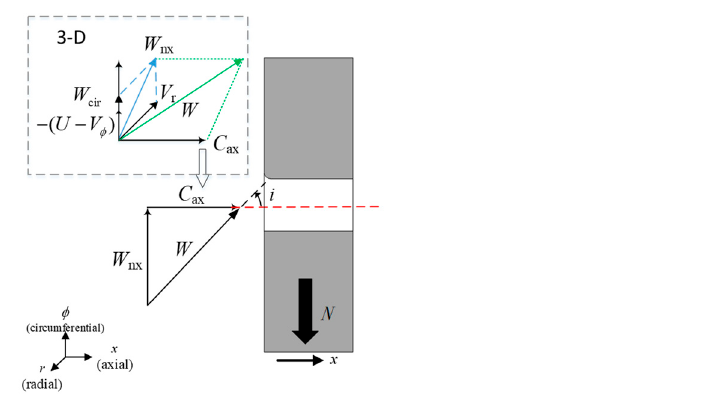
Figure 2. Velocity triangles at the orifice with complex inlet flow conditions.